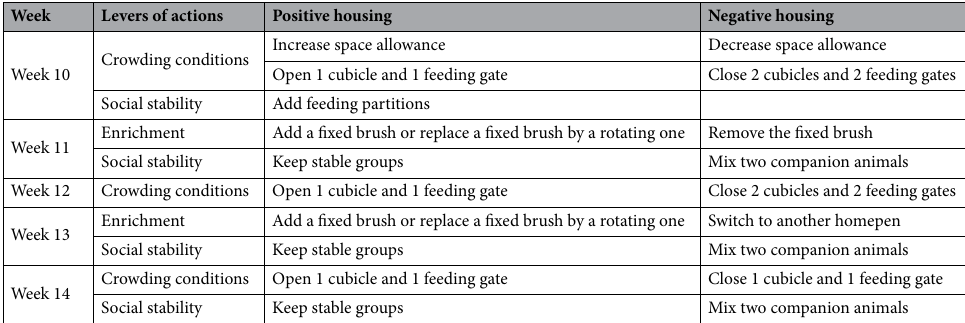
Table 6. Detailed treatment applied every Friday during the experimental conditions to design the positive and negative housing conditions.